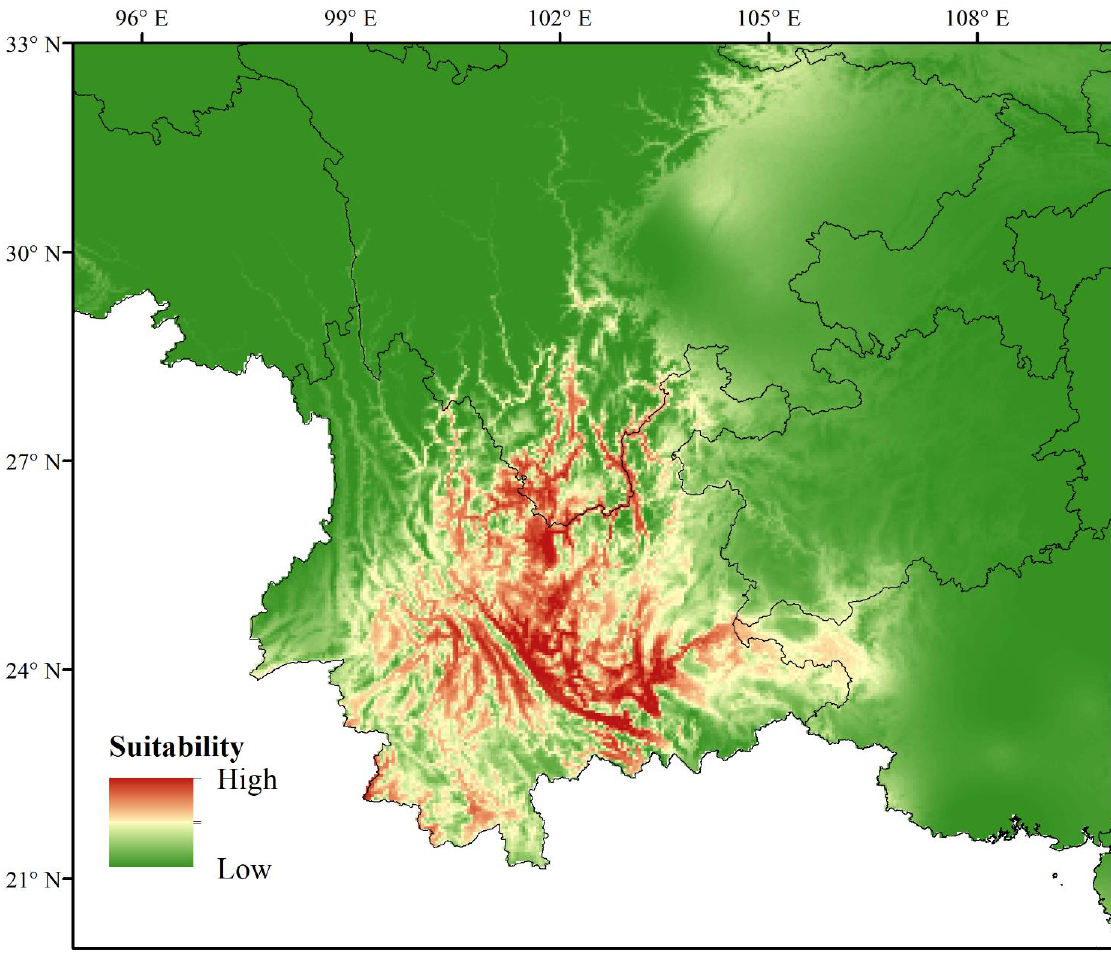
Figure 3. Predicted habitat suitability of Garuga forrestii under current climatic conditions.